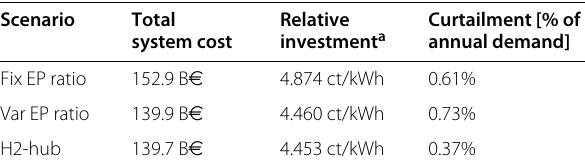
Table 3 Annual total system costs, relative investment and curtailment data. Variable sizing of energy storage reduces the system costs by 10%